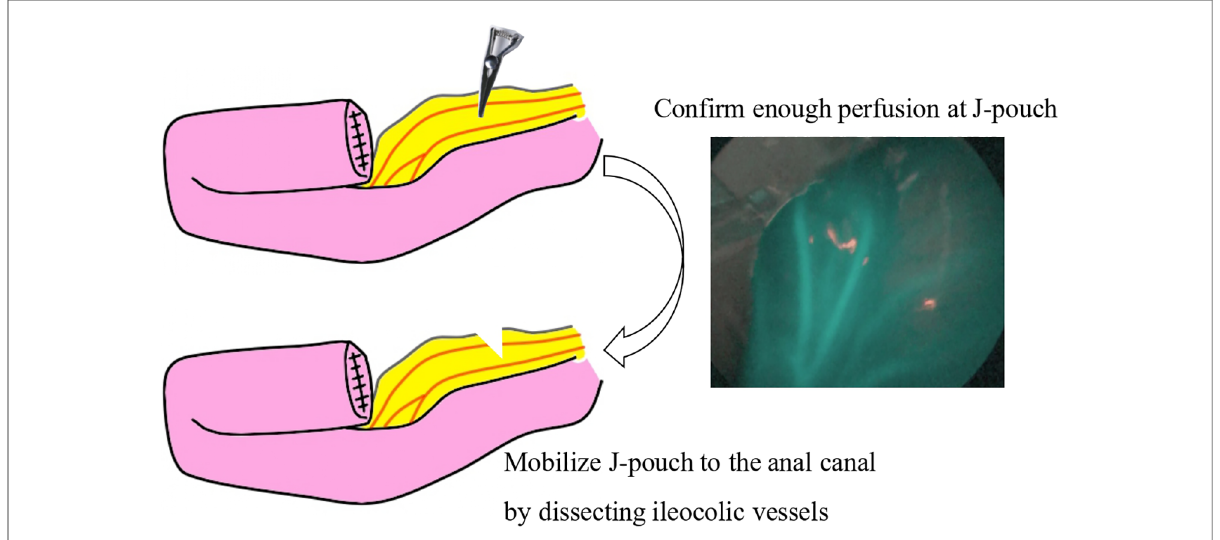
FIGURE 2 When pulling the J-pouch through the anal canal, it was mobilized by dissecting the mesenchyme after con fi rming adequate retention for perfusion by indocyanine green fl uorescence angiography with a vessel clamp. Indocyanine green was intravenously injected with a dose of 0.01